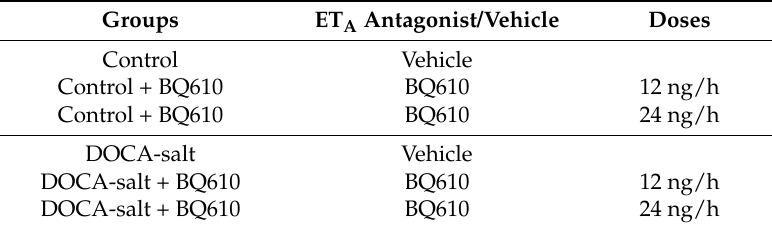
Table 3. Experimental groups used in the present